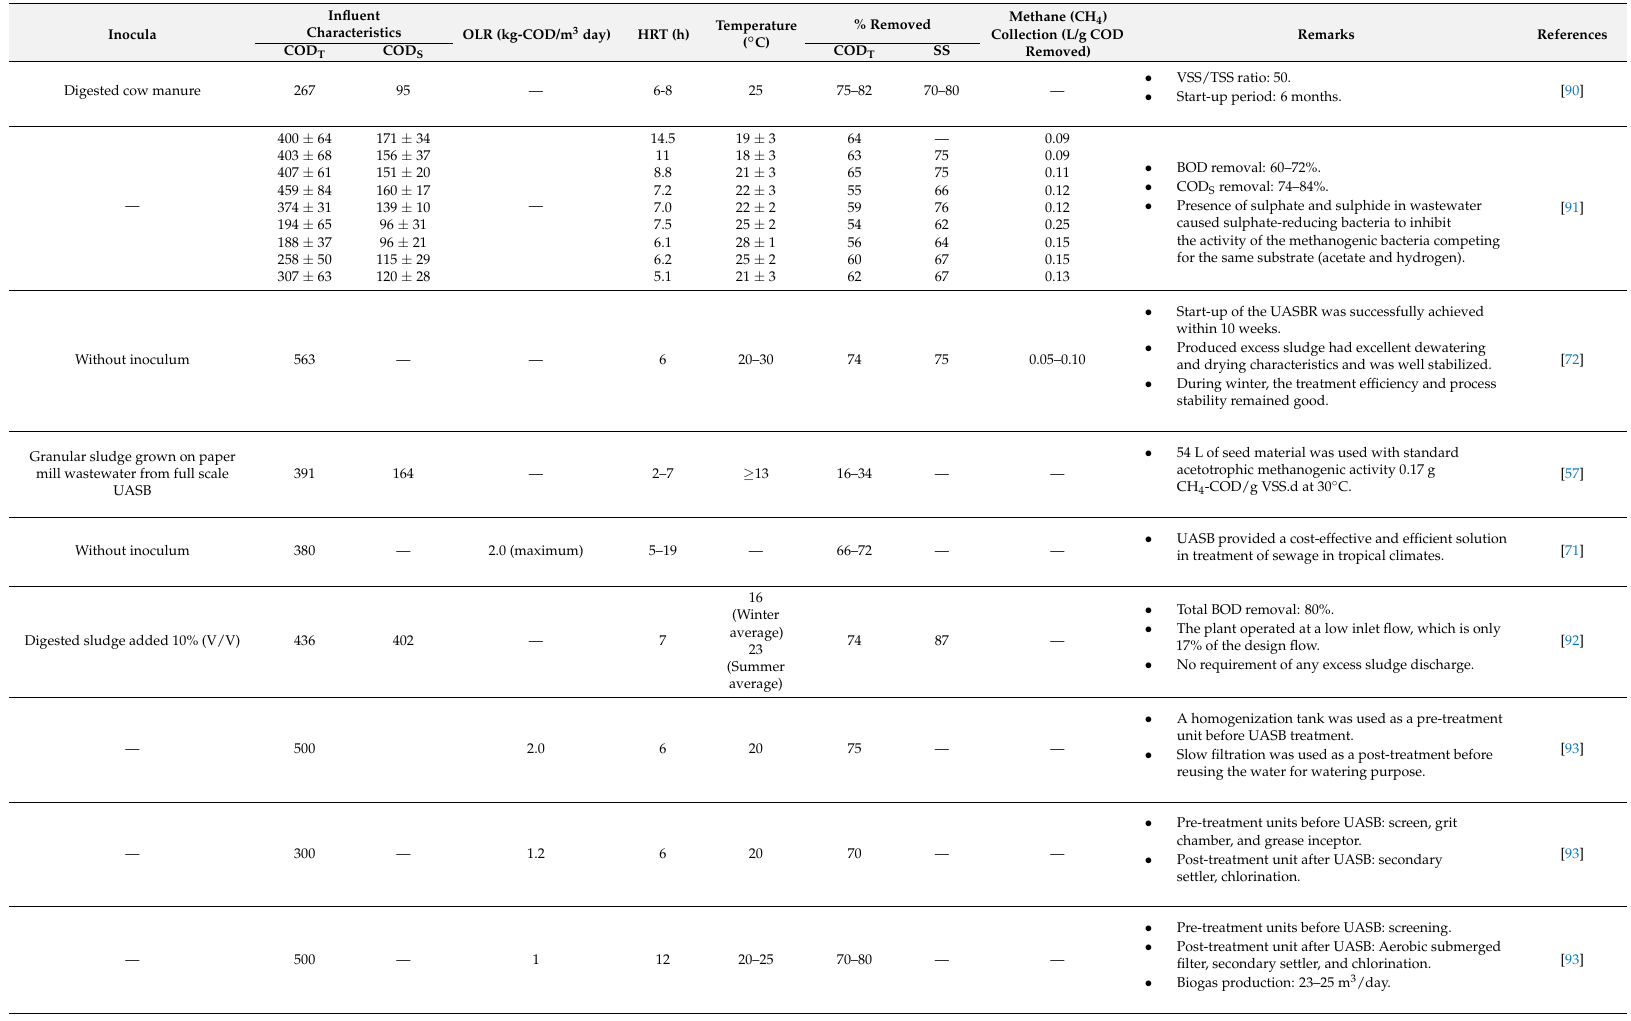
Table 3. Selected key operating parameters and performance of pilot to full-scale (reactor size range 20–30,000 m 3 ) UASB systems studied by different researchers.